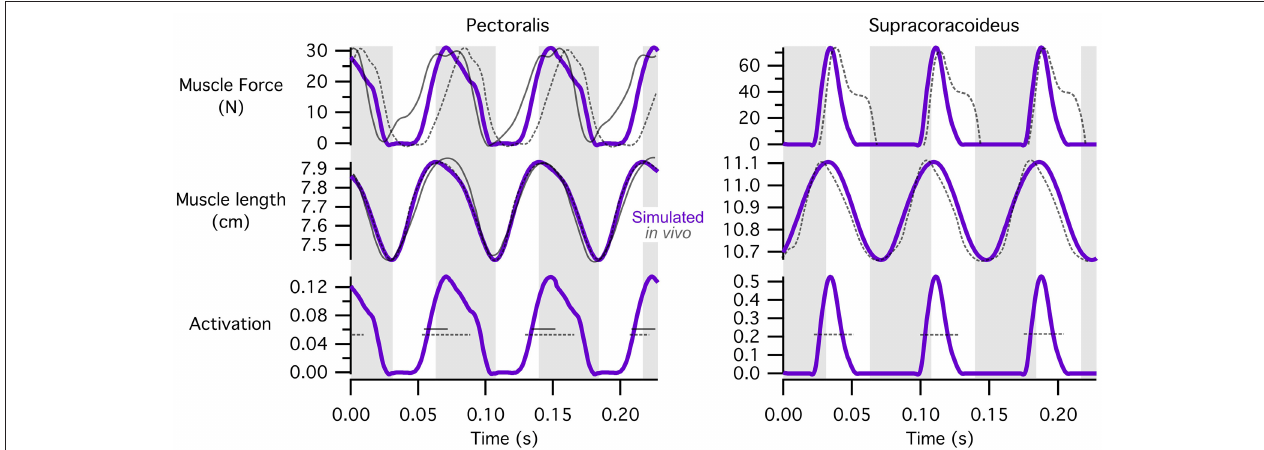
FIGURE 5 | Patterns of muscle activation, changes in length, and force development. Simulation estimates of muscle activation, shortening vs. lengthening, and force development are qualitatively similar to patterns reported for flying (Tobalske and Biewener, 2008) or flap-running (Jackson et al., 2011a) pigeons. Simulated chukar data is in purple; in vivo/in vitro pigeon data is in gray; solid lines, flap-running on 65 ◦ inclines; dashed lines, ascending flight. Gray regions indicate simulated shortening of the pectoralis muscle. Lengths represent muscle-tendon lengths in chukars. Pigeon forces and lengths are expressed as stresses and strains, respectively; pigeon muscle “activity” is actually muscle excitation (EMG), which precedes activation; axes for pigeon data are not shown. All comparisons are based on adult birds.